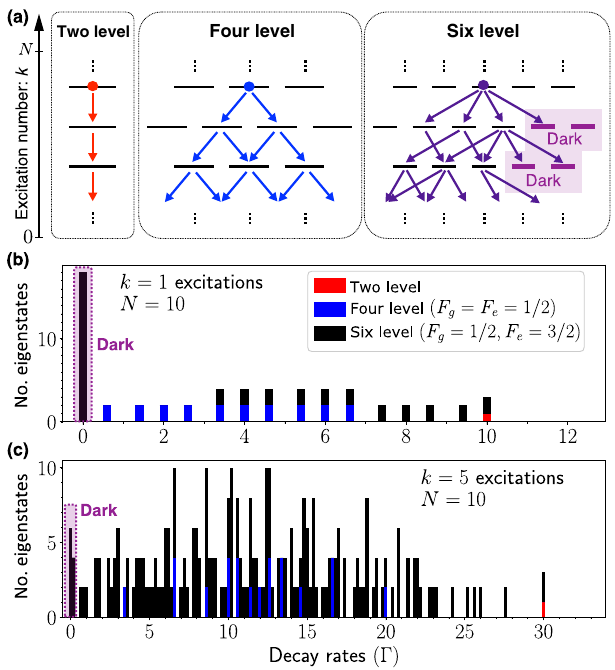
FIG. 3. Collective eigenstates and decay cascades. (a) Concep- tual depiction of the decay down the tree of collective eigenstates. Vertically aligned black lines represent eigenstates of fixed number of excitations k and colored arrows represent possible decay processes. For two-level systems, the decay path is unique. For four-level systems, each eigenstate typically decays into two other eigenstates. For six-level systems, each eigenstate can potentially decay into several eigenstates and some of them might be dark. (b),(c) Histograms of the decay rates ( γ = Γ ) of all collective eigenstates with (b) k ¼ 1 and (c) k ¼ 5 excitations for N ¼ 10 . We show results for a two-level system, a four-level 1 = 2 , and a six-level system with F F system with F g ¼ e ¼ g ¼ 1 = 2 and F 3 = 2 e ¼